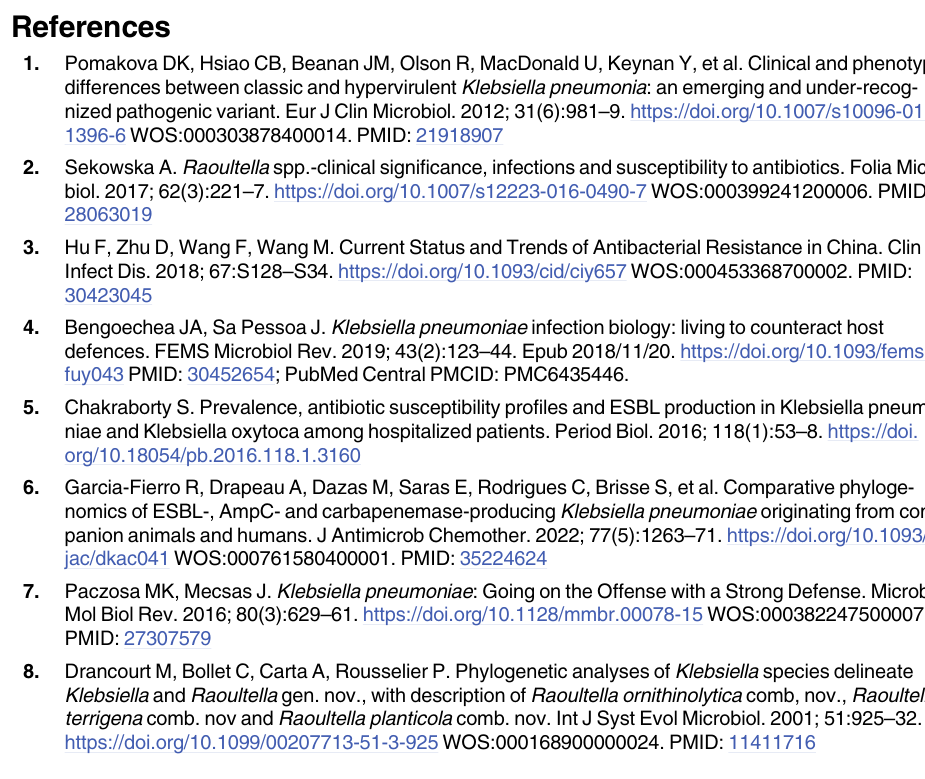
S1 Fig. The diagram of the modified string test. S1 Table. The sequences of beta-lactam resistance genes of four ESBL-producing isolates. S2 Table. The sequences of the virulence-related